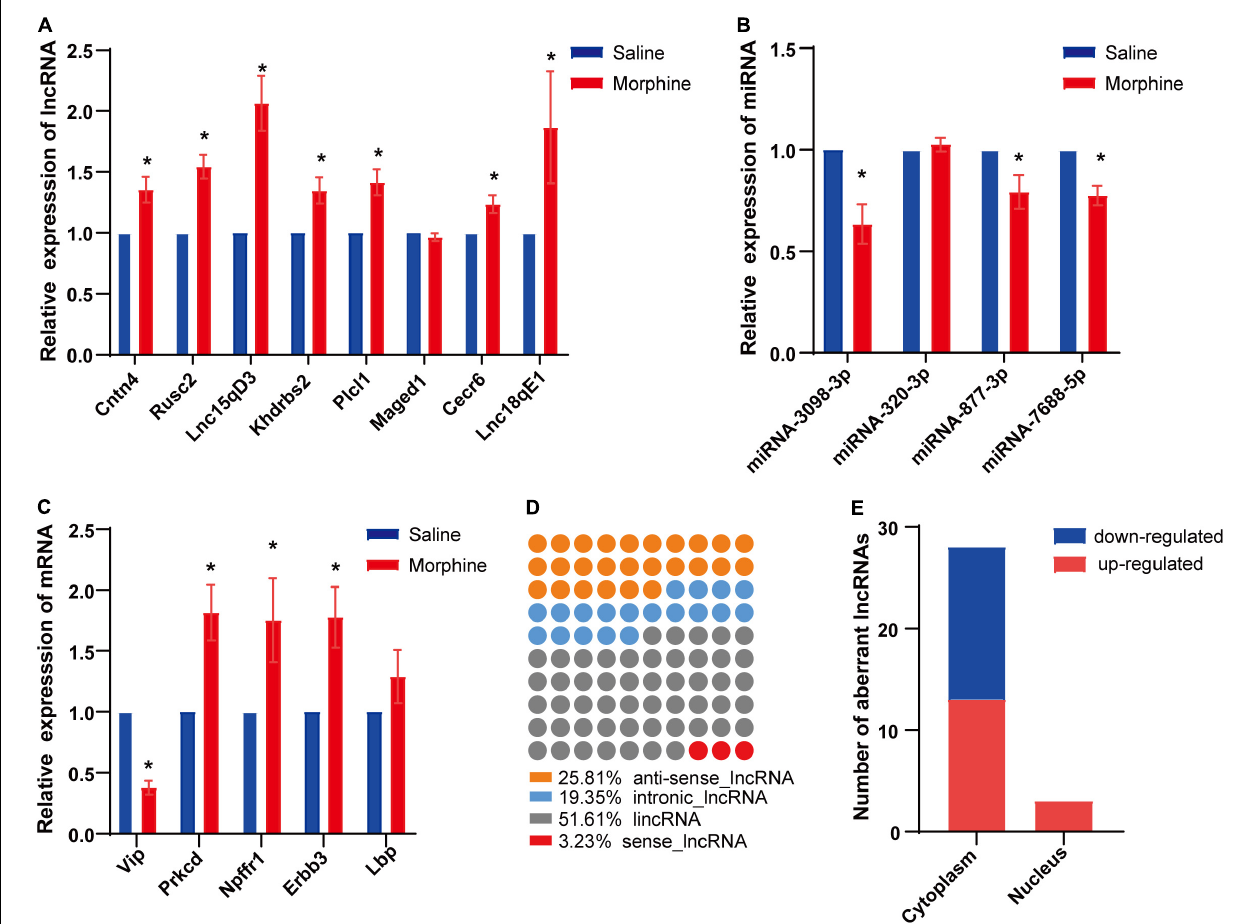
FIGURE 3 | Differential expression of distinct RNAs and characteristics of LncRNAs. The relative expression levels of eight lncRNAs (A) , four miRNAs (B) and five mRNAs (C) are shown by comparing the morphine group with the saline group via qRT-PCR. The data are presented as the mean ± SEM, n = 4, * p < 0.05. Subclasses (D) and subcellular localization (E) of significantly dysregulated lncRNAs were